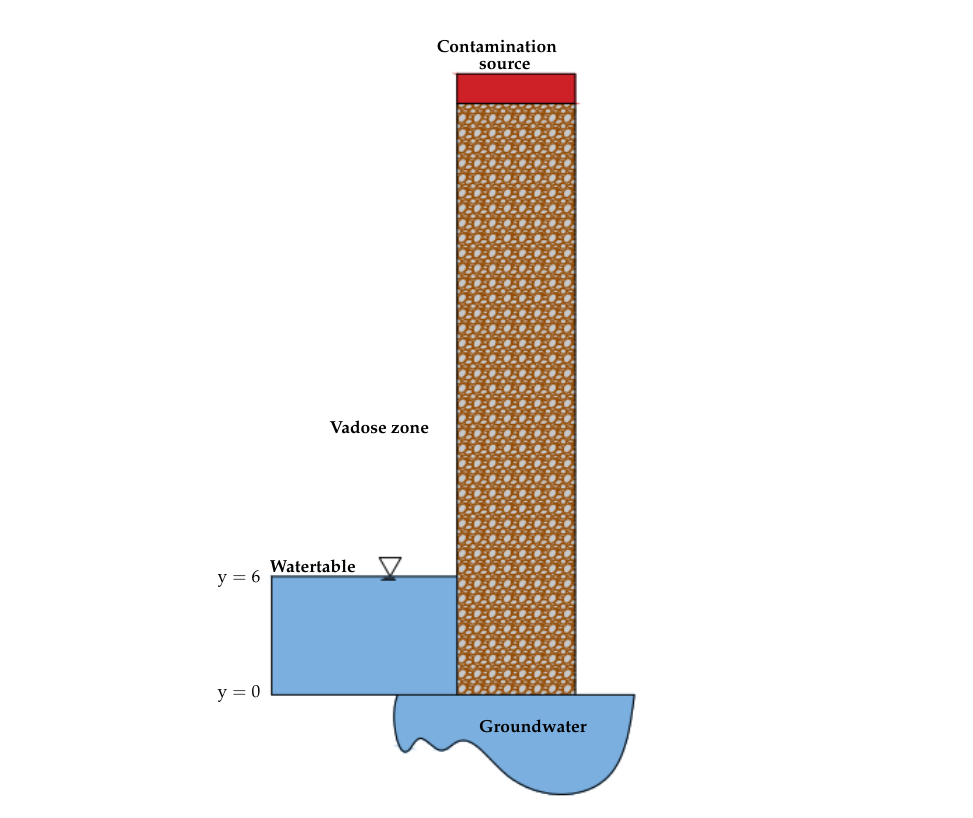
Figure 2. Depiction of the applied boundary conditions and geometry.